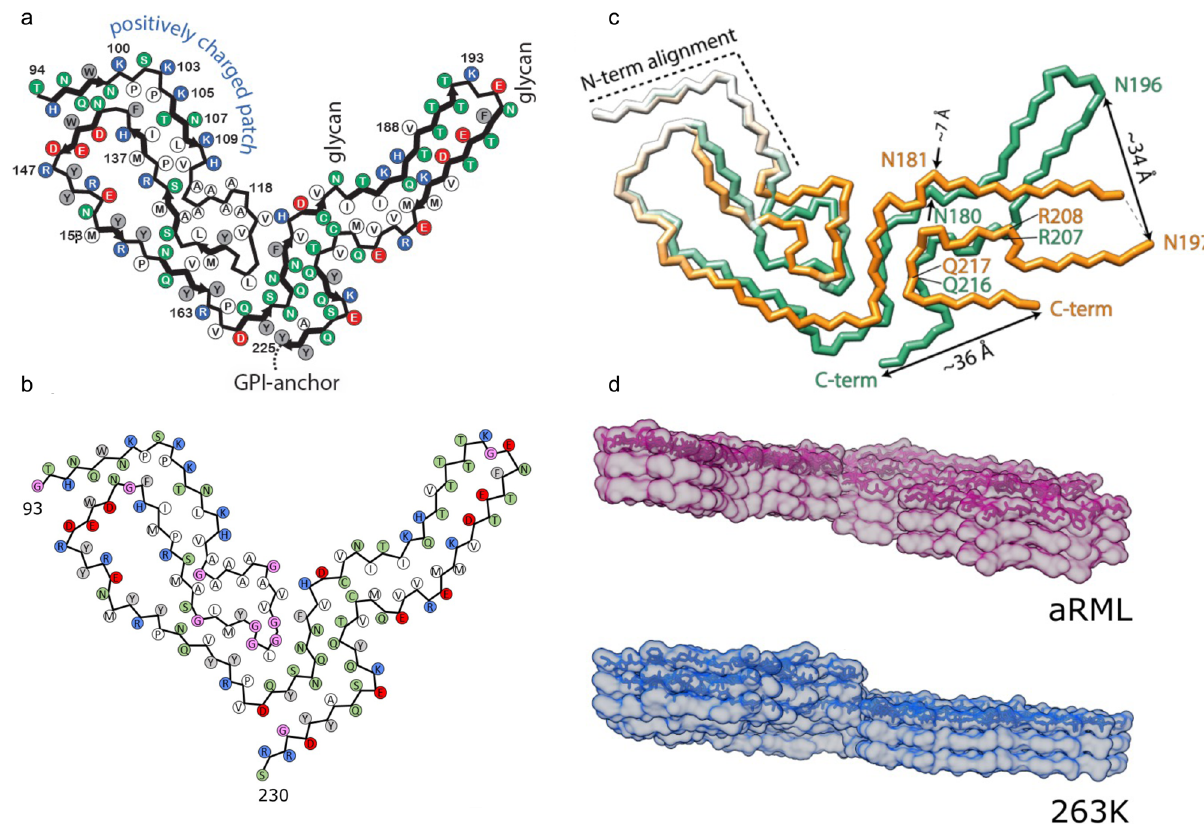
Fig. 1 Structures of RML, aRML, and 263 K prions from cryo-EM. Core sequences of PrP subunits in a RML fi laments and b aRML fi laments. c Comparison of PrP conformations in RML and the 263 K prion fi brils. d Lateral views of aRML and 263 K fi brils showing stacks of three rungs. a and c are adapted from Manka et al.; b and d are adapted from Hoyt et